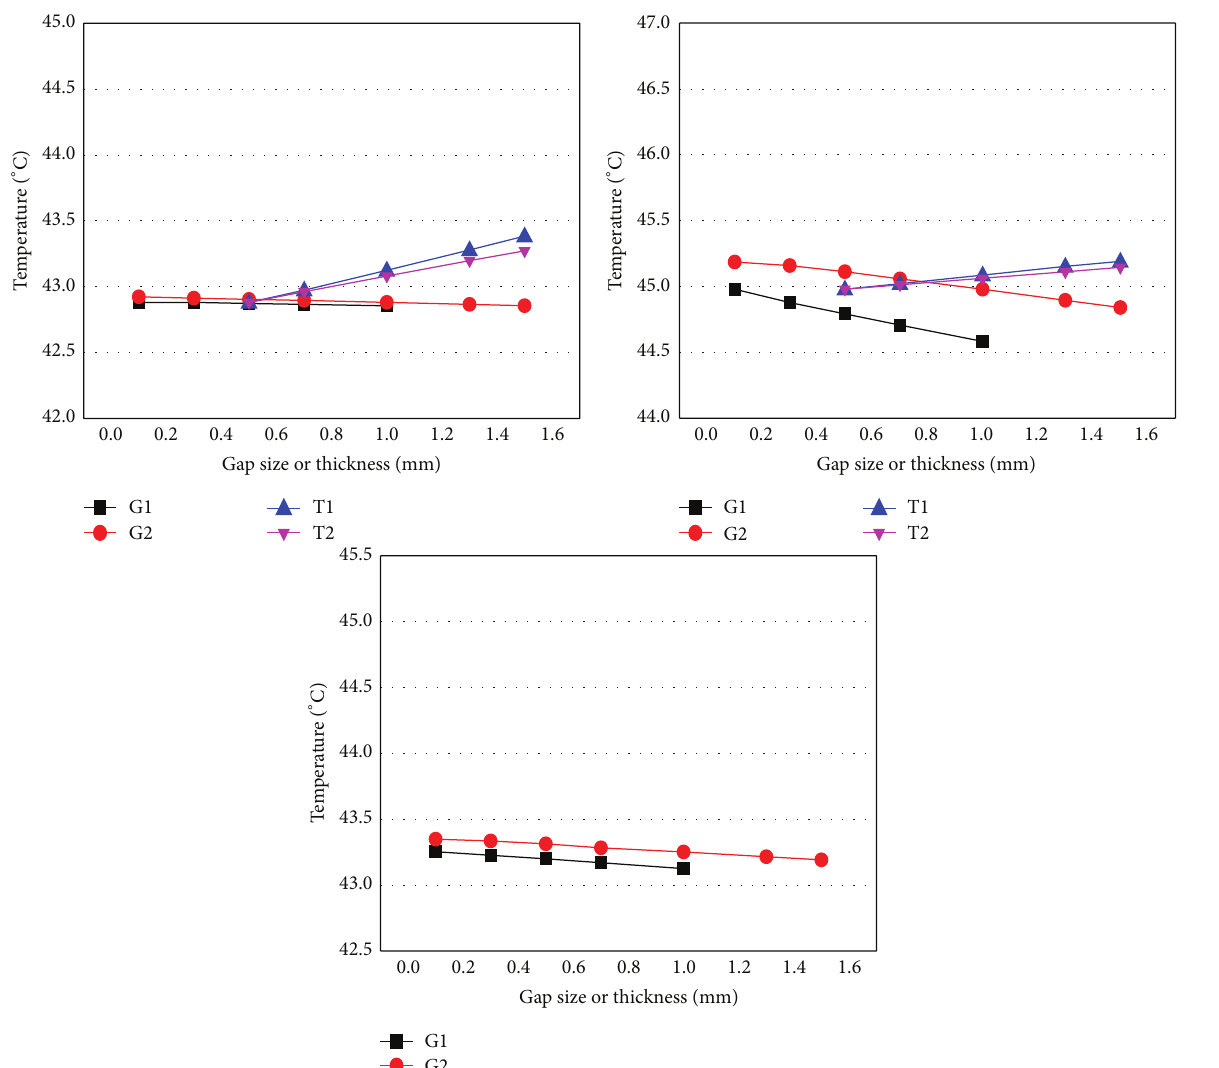
Figure 7: Effects of gaps G1 and G2 and container thicknesses T1 and T2 on the surface temperature (from left: NaK/LBE/Al thermal media).